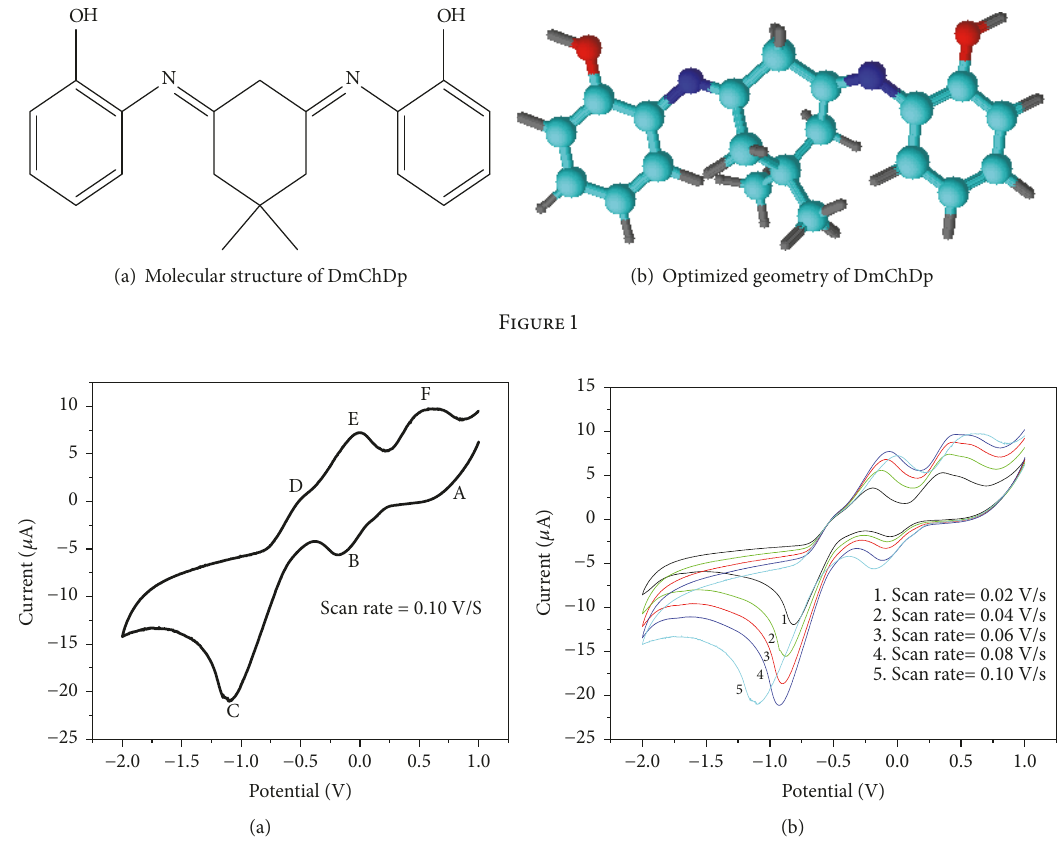
Figure 2: (a) Cyclic voltammogram of DmChDp at a scan rate of 0.10 V/s. (b) At scan rates 0.02-0.10 V/s.